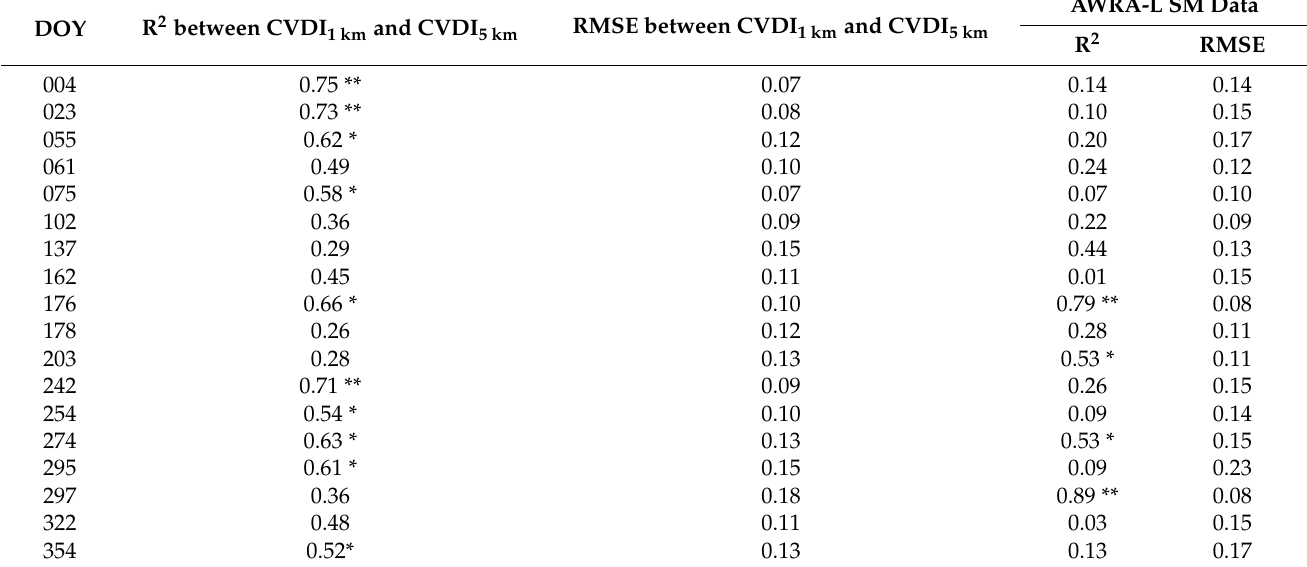
Table 4. Estimation results between CVDI 5 km and CVDI 1 km , Australian Water Resource Assessment Landscape (AWRA-L) SM data for the 18 days. DOY R 2 between CVDI 1 km and CVDI 5